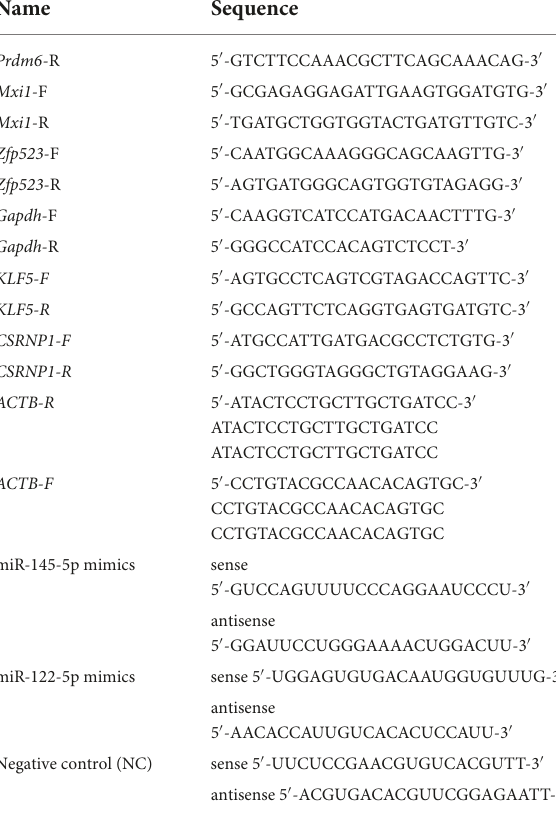
TABLE 1 Primers for qRT-PCR and nucleotide sequences for